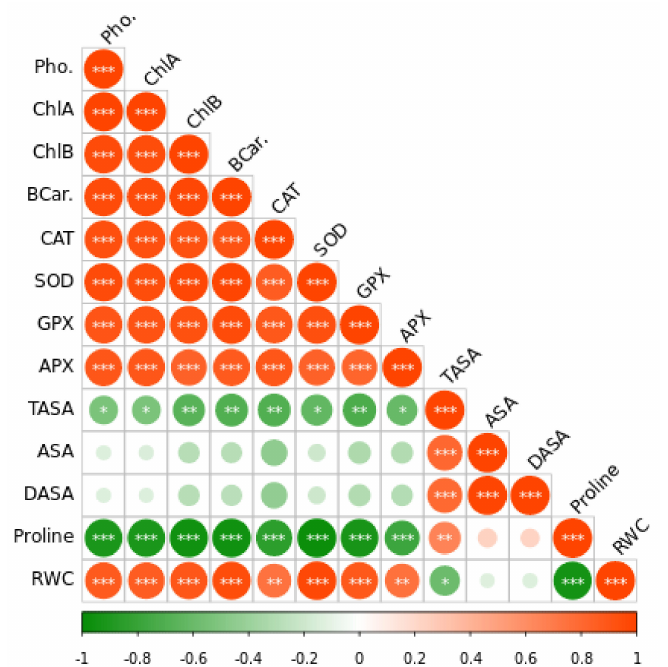
Figure 7. The Pearson correlation matrix for leaf relative water content (RWC), dehydroascorbate (DHA), reduced ascorbate (ASA), total ascorbate (TASA), ascorbate peroxidase (APX), glutathione peroxidase activity (GPX), superoxide dismutase (SOD), catalase (CAT) photosynthesis (Pho). Pear- son’s correlation was calculated and heat maps were visualized by R Statistical computing software (version 4.1.3). (*) p < 0.05; (**) p < 0.01; (***) p <